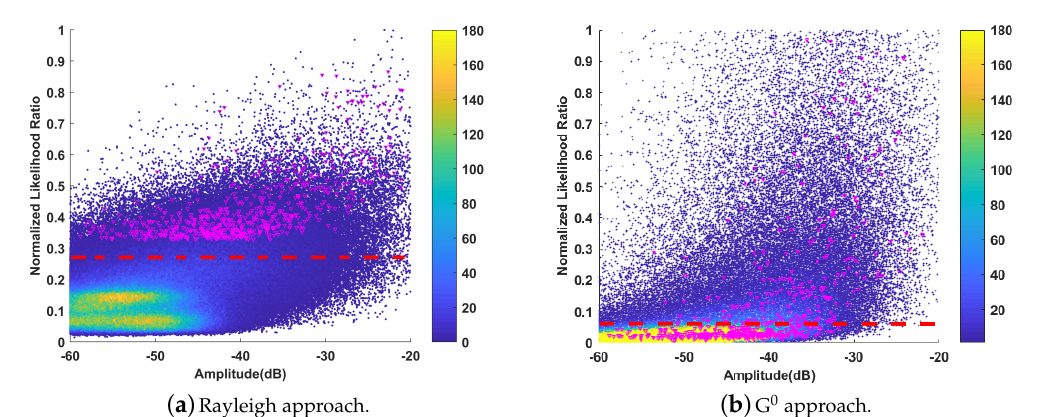
Figure 18. The scatter density diagrams of pixels. ( a ) Rayleigh approach. ( b ) G 0